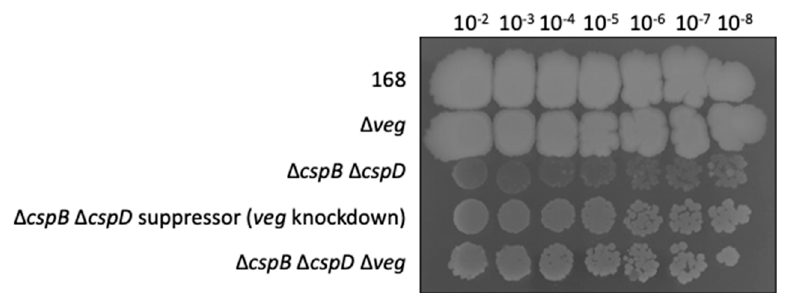
Figure 4. Growth of veg knockdown and knockout mutants in the Δ cspB Δ cspD background. The